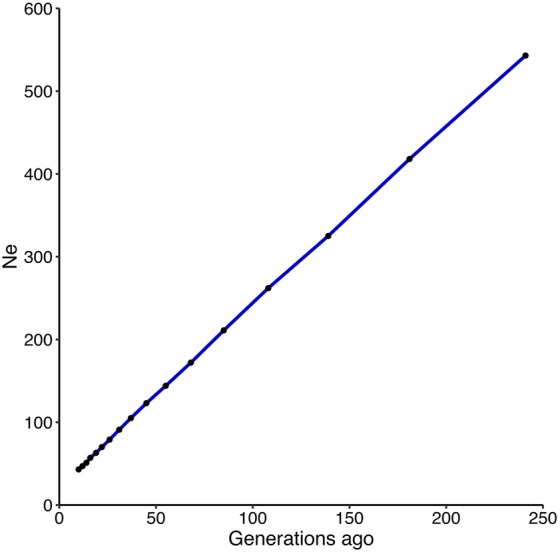
Effective population size estimation in coho salmon population. Estimates of effective population size (Ne) over the past 241 generations based on the LD of an aquaculture strain of coho salmon. Black dots represent each Ne measurement.